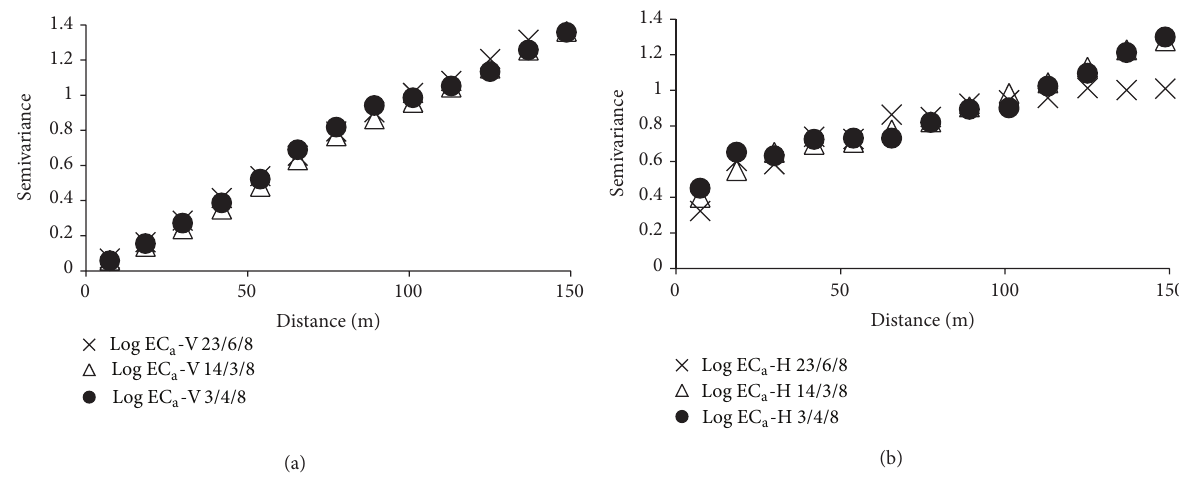
Figure 4: Standardized sample semivariogram for log EC